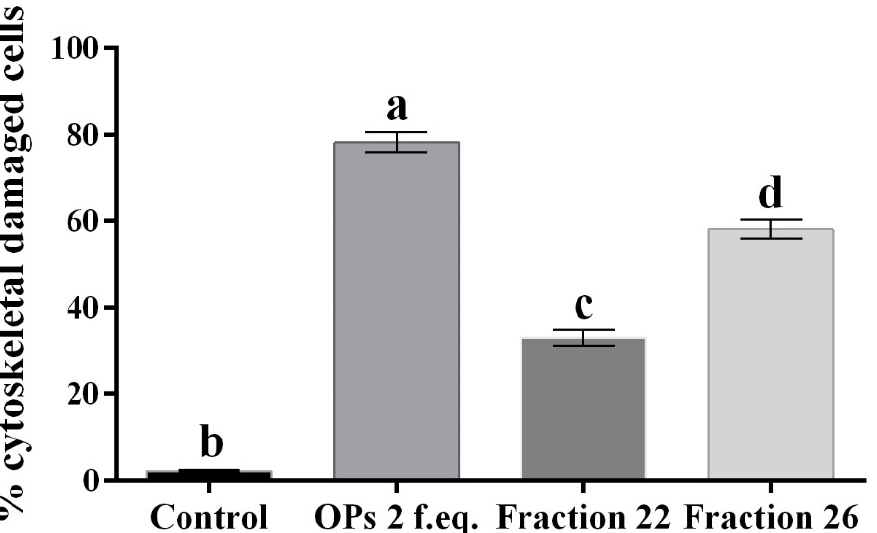
Figure 6. Percentage of hemocytes stained with TRITC-conjugated phalloidin showing cytoskeletal damage, after treatment with 1 × PBS (control), OPs deriving from two equivalent females (2 f. eq.), HPLC fractions #22 and #26. Data are reported as mean ± SD of n = 3 independent experiments. Statistical analysis was performed with one-way ANOVA and Bonferroni post hoc test. Different letters indicate significant differences ( p value < 0.0001).